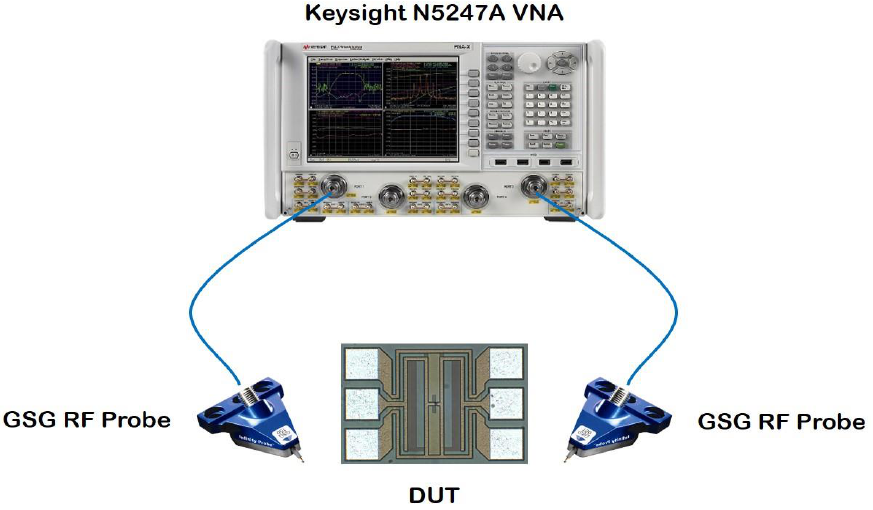
Figure 10. Measurement setup for the proposed BPF.